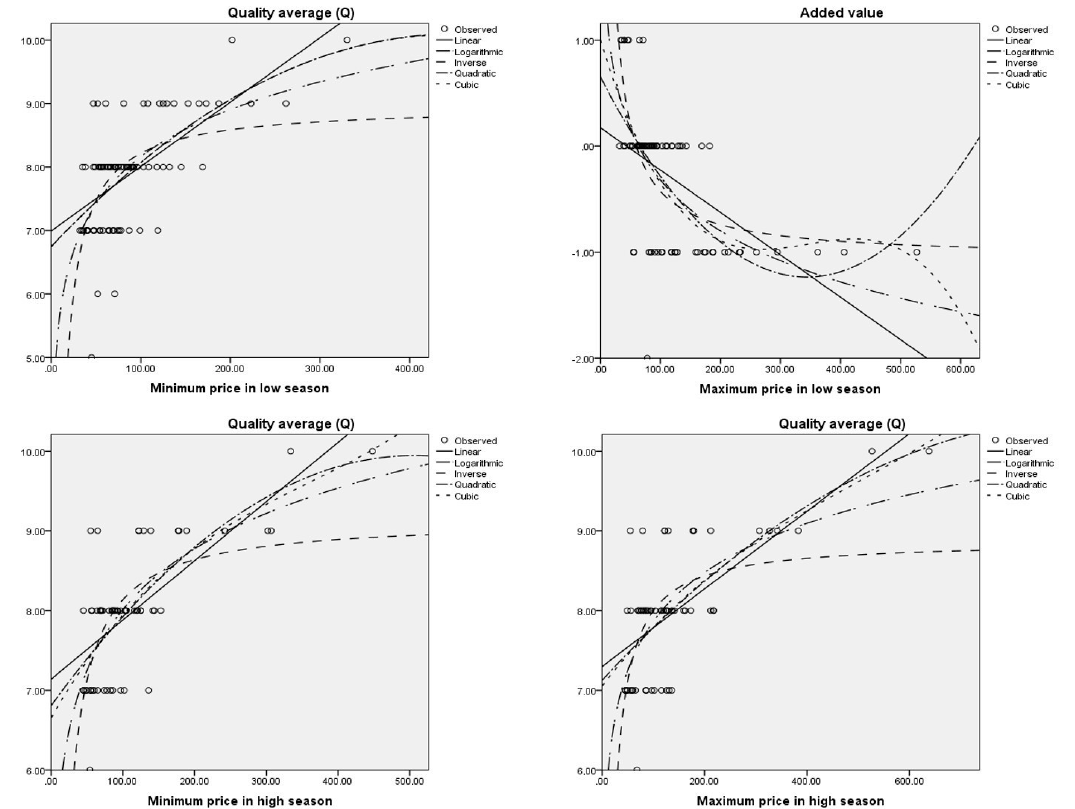
Figure 3. Functions of the regression analysis with the best fit in the Tenerife destination.